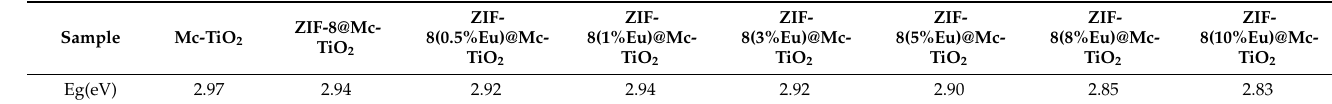
Table 2. List of material forbidden band widths.